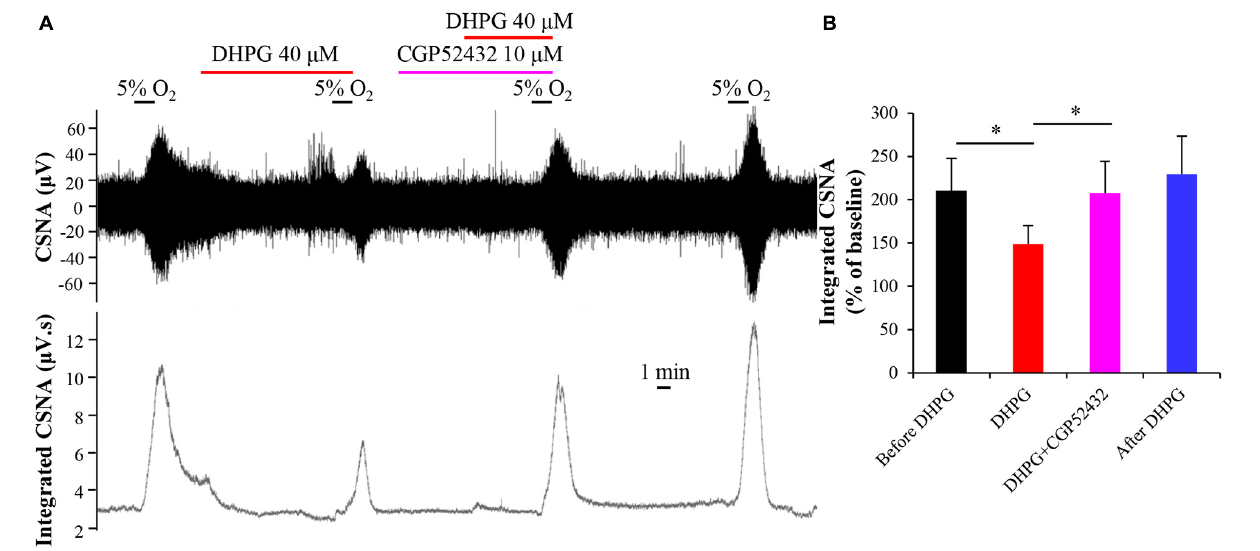
FIGURE 6 | GABA B receptor antagonist CGP52432 blocks inhibitory effect of DHPG on CB response to hypoxia. (A) Representative traces of changes in raw CSNA and integrated CSNA recordings. Note that pretreatment with CGP52432 prevents the inhibitory effect of DHPG on CSNA under hypoxia conditions. (B) Statistical analysis of normalized integrated CSNA after difference treatment. The data were presented as mean ± SEM. n = 5, ∗ p < 0.05 indicates significant difference (one-way ANOVA with repeated measures). CSNA, carotid sinus nerve activity; CGP52432, GABA B receptor antagonist; DHPG, group I mGluRs